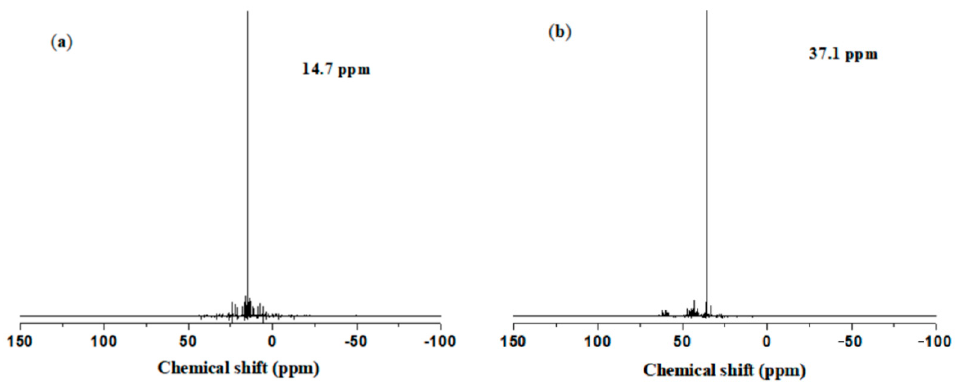
Figure 4. 31 P NMR spectra of DOPO ( a ) and LPFA ( b ).